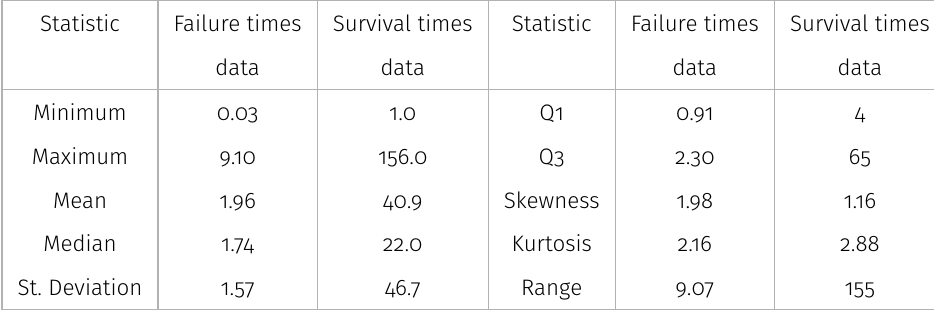
Table II. Descriptive statistics of both data